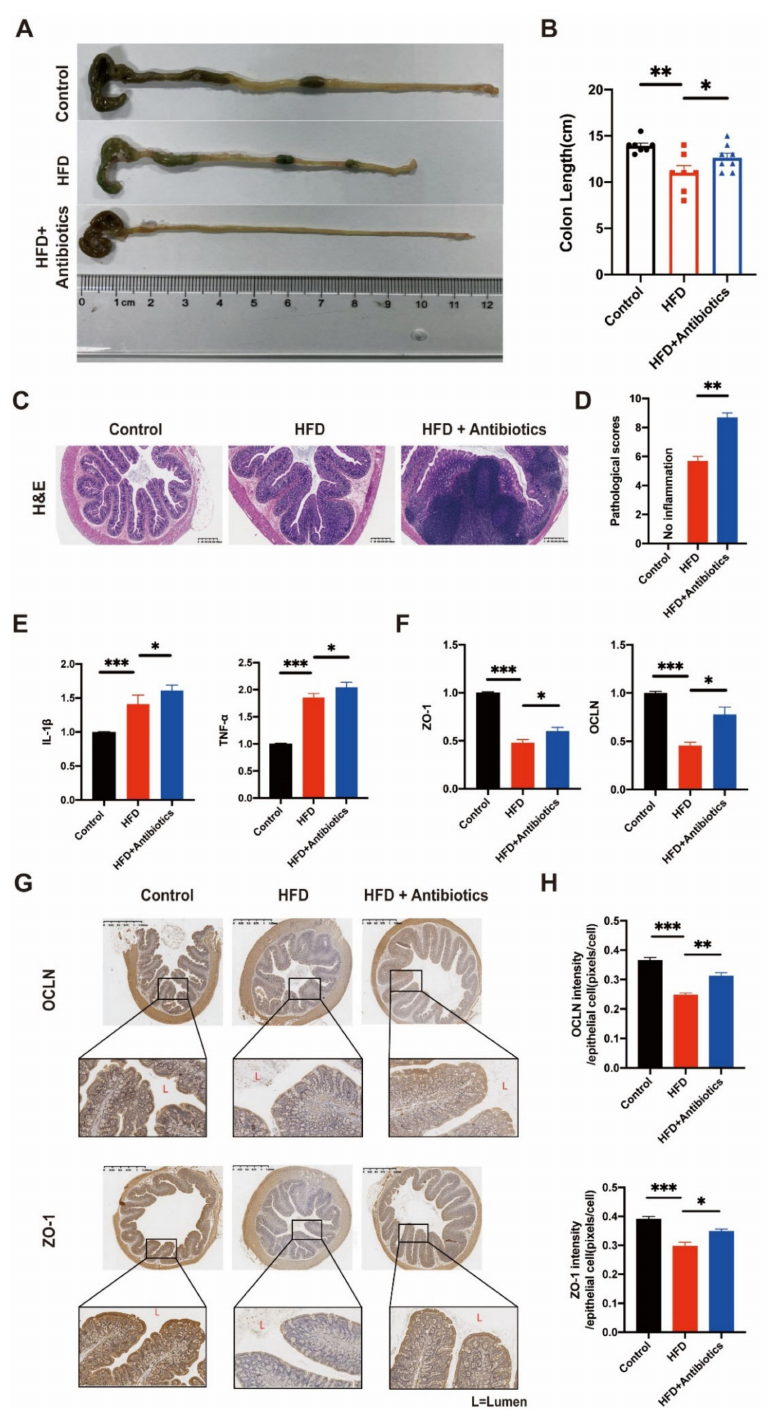
Figure 2. Treatment of a high-fat diet could induce intestinal inflammation and barrier dysfunction in rats. ( A , B ) Rat colons were removed and shown in ( A ), colon length from the Control, HFD, and HFD+Antibiotics groups were measured. ( C , D ) Haematoxylin and eosin staining of colon tissue sections collected from rats treated as above. Scale bars represent 400 µ m. HE was calculated histopathological inflammation scores ( D ). ( E , F ) mRNA expression of ZO-1, OCLN, TNF- α , and IL-1 β are shown as relative fold to control normalized to GAPDH. ( G , H ) Immunohistochemical staining of ZO-1 and OCLN was detected in three groups ( G ), and quantitative evaluation ( H ) of the expression of ZO-1 and OCLN in the intestinal mucosa. Scale bars represent 1.25 mm. Data represent means ± SEM. * p < 0.05; ** p < 0.01; *** p < 0.001. (Control, n = 7; HFD, n = 7; HFD+Antibitics, n =